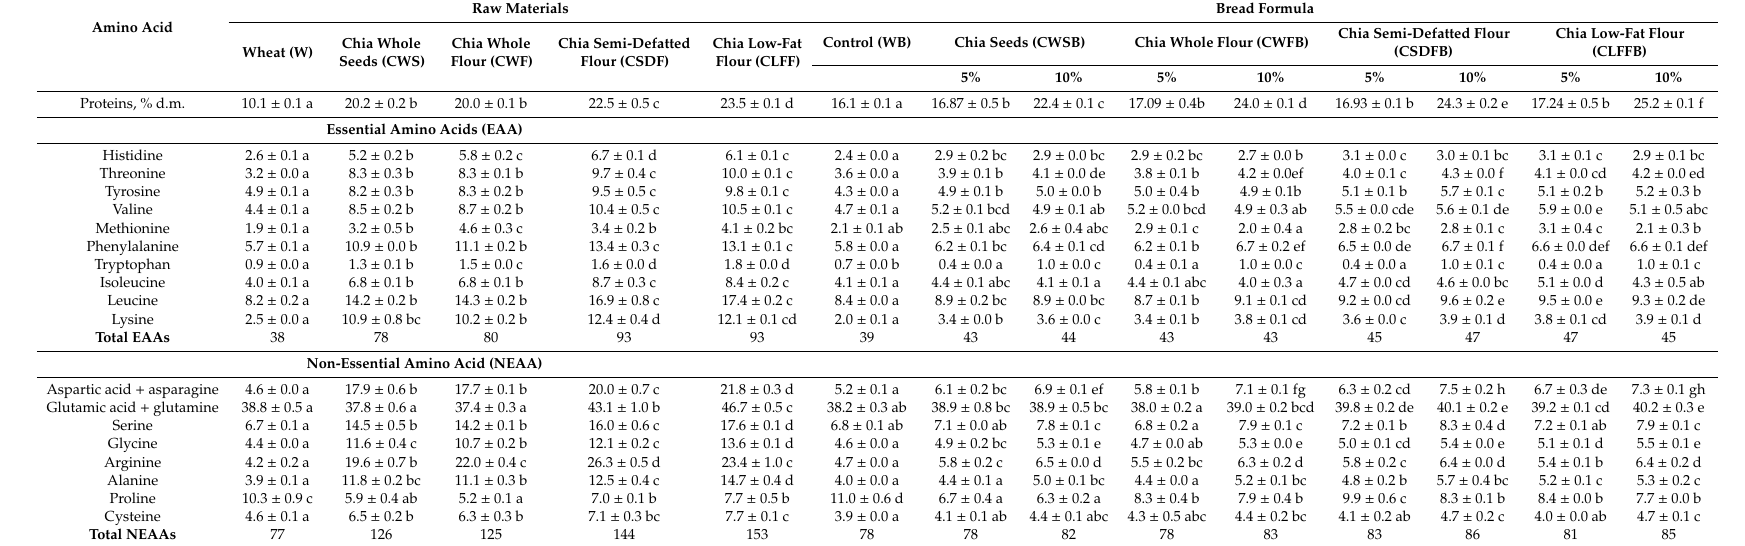
Table 1. Amino acid composition of raw materials used in this study, mg / g of bread in dry matter a .